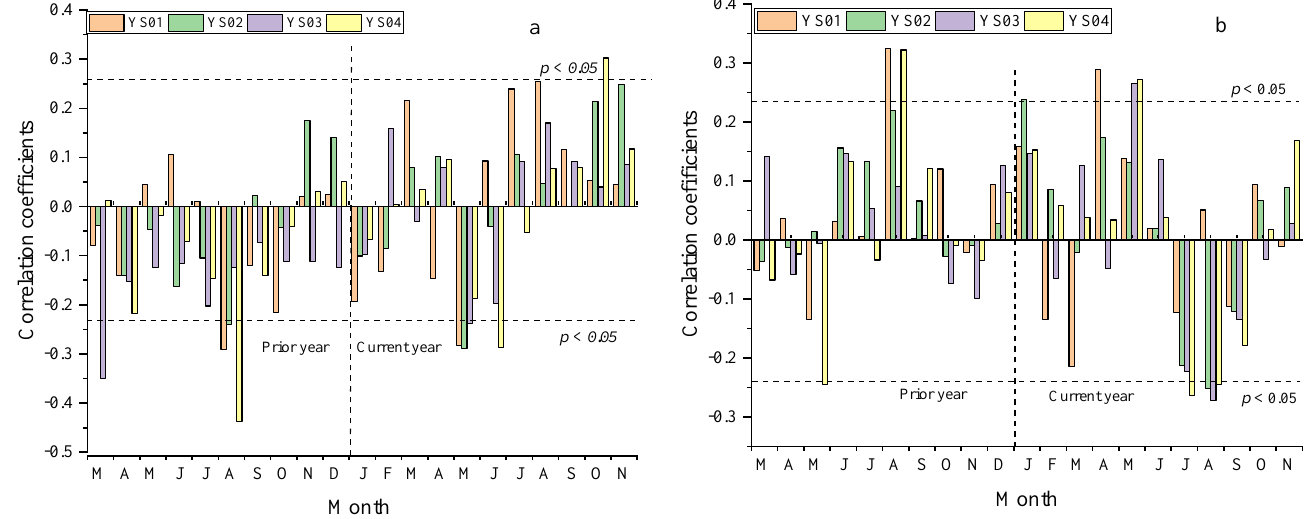
Figure 4. Correlations between chronologies and regional T ( a ) and P( b ) from 1961 to 2016. Correlation results with regional P indicate different significant correlations with four residual chronologies (Figure 4b). Significant negative correlations with P are found in prior May and current July at YS04 site and in current August at YS02, YS03 and YS04 sites. Significant positive correlations are found in prior August at YS01 and YS04 sites, current May at YS03 and YS04 sites, current April at YS01 site, and current January at YS02 site,